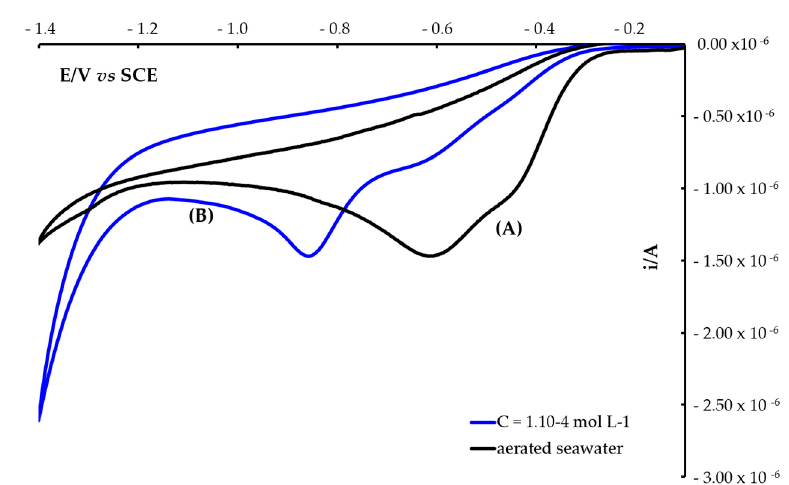
Figure 3. Cyclic voltammograms of aerated artificial sea water on functionalized gold electrode by AgNPs obtained by metalorganic deposition (E Au/AgNPs ) without nitrate ( A ) and with nitrate [NO 3 − ] = 10 − 4 mol · L − 1 ( B ). Start potential − 0.10 V and end potential − 1.3 V. Artificial sea water, [NaCl] ~ 0.6